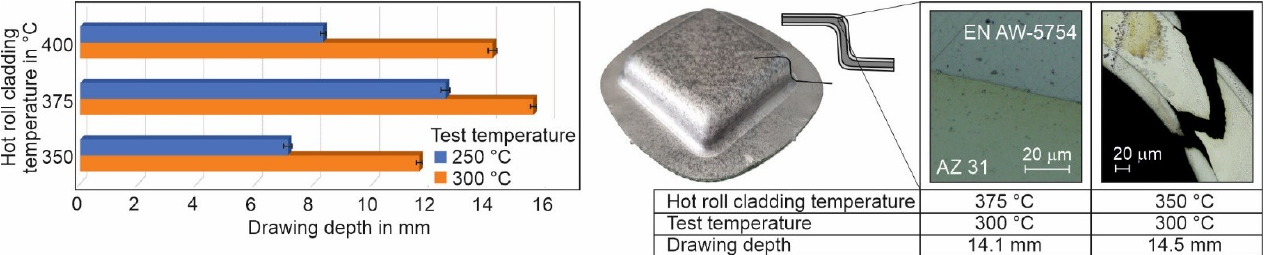
Figure 7. Drawing depth at different test temperatures.